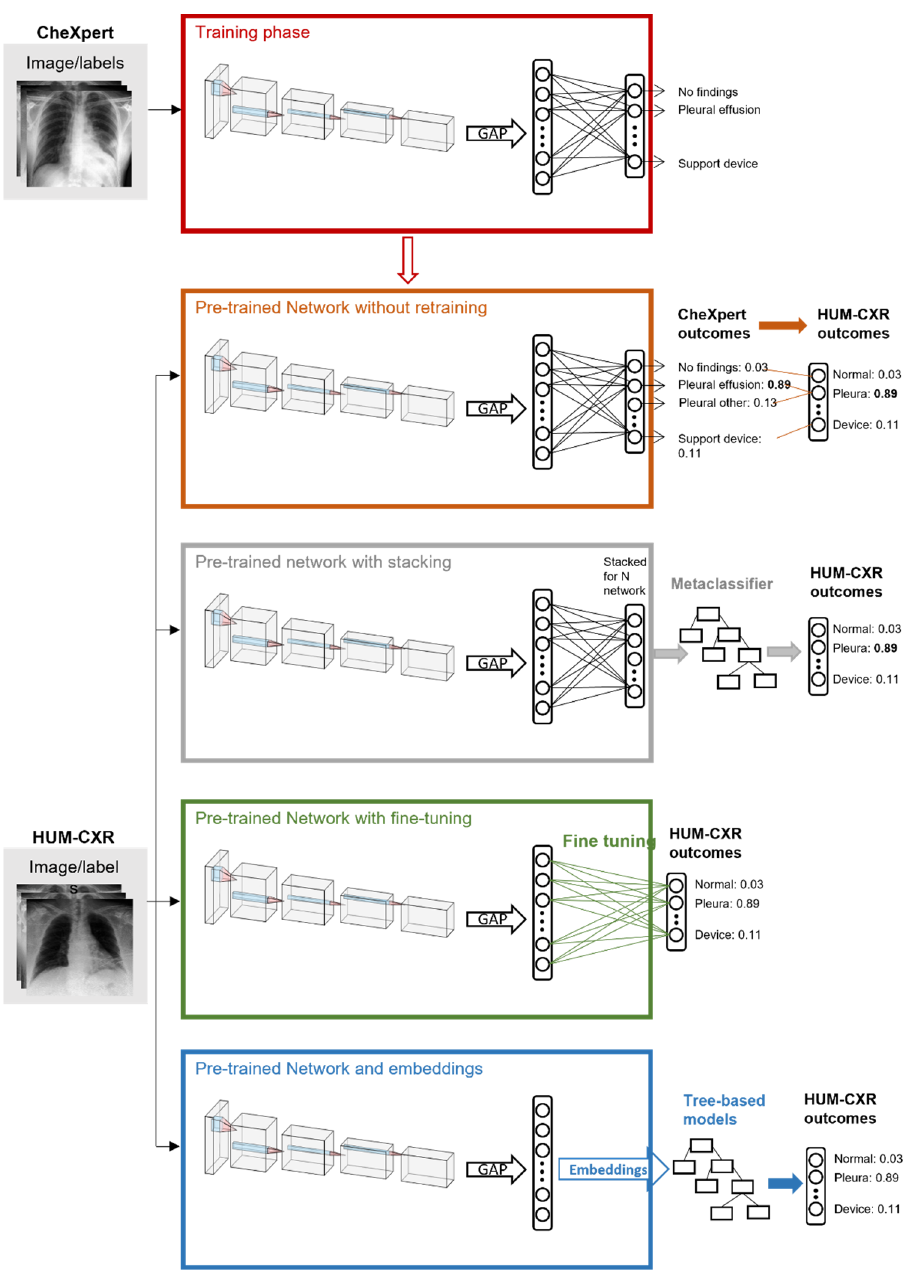
Figure 2. An overview of our experimental design. In the first phase, state-of-the-art image classification networks were tuned on a large public dataset of X-rays (CheXpert [14]). Then, we performed four different steps on the HUM-CXR dataset: (1) we tested the originally trained networks on the X-rays of the new dataset, mapping the HUM_CXR labels to CheXpert labels; (2) we used the originally pretrained networks with a metaclassifier to combine the predictions of each network on the new dataset; (3) we fine-tuned the networks by removing the fully connected classification layer from the seven CNNs trained on CheXpert and replacing it with a seven-output layer that matched HUM-CXR labels; and (4) we extracted the image embeddings from each network and trained tree-based classifiers to predict the HUM-CXR labels starting from the extracted embeddings.